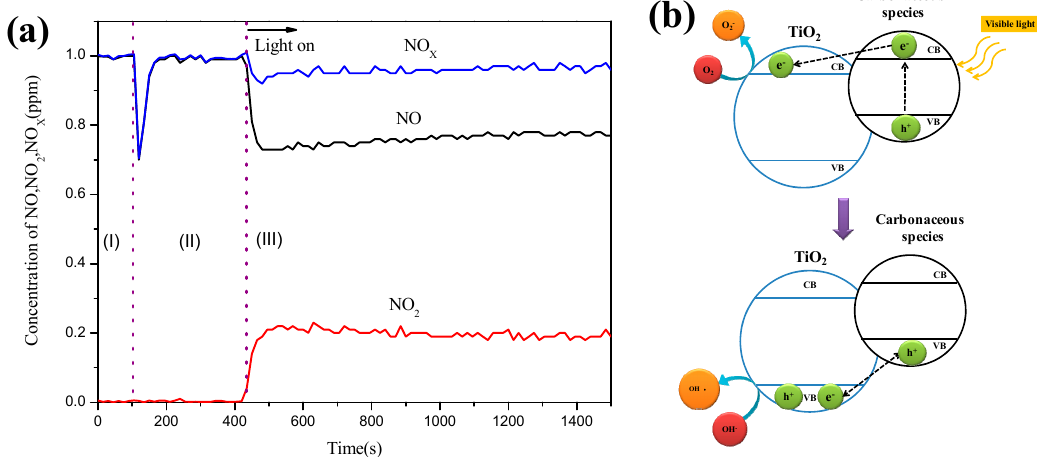
Figure 1. ( a ) Time-course of the changes in concentration of NO, NO 2 , and NO x in the presence of 100% C–TiO 2 film under visible light (blue LED); sample size: 8 × 10 cm 2 , inlet concentration of NO: 1 ppm, inlet flow rate: 1 L/min, irradiation intensity of visible light: 2.50 mW/cm 2 , respectively, reaction temperature: 20 °C, relative humidity: 37%. ( b ) Schematic drawing of the mechanism of photocatalytic degradation under visible light for carbon-modified TiO 2 .